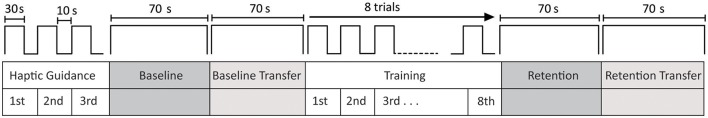
Experimental protocol. Haptic guidance was employed to help subjects to understand the locomotor task. Three trials of 30 s with the robot passively moving the subjects' legs were employed to present the locomotor task. During baseline, subjects actively tracked the Lissajous figure during 70 s in no perturbation mode. Subjects performed a second baseline test (baseline-transfer), where they tracked a similar figure but with the left leg with the smallest amplitude. During training, subjects played with no perturbation, error amplification or random force disturbance, depending on their training group. Each training session consisted of eight trials of 30 s of movement with 10 s rest between trials. The short-term retention and transfer tests followed the same structure and order as baseline and baseline-transfer tests. Subjects were scanned by the fMRI during all phases.